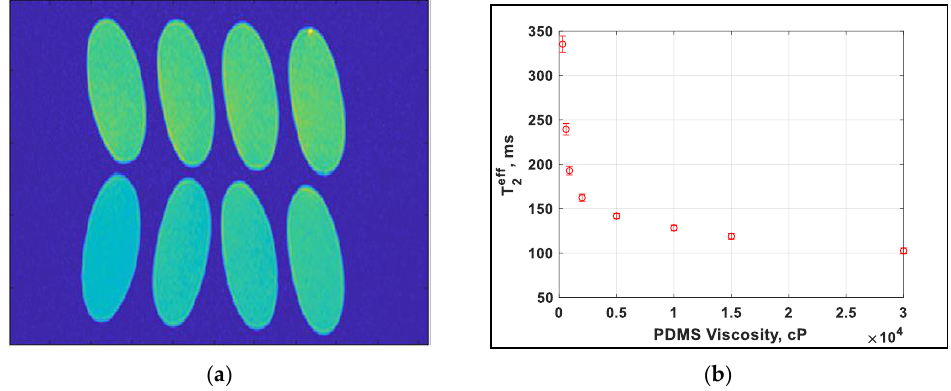
Figure 5. ( a ) Image of the final echo of the echo image from MRI showing the range of values experienced. Viscosity in cP is labelled ( b ) dependence of T 2eff on the PDMS viscosity. The values as determined for the T 2eff from the CAPIBarA are plotted against those from the MRI in Figure 6 and show a correlation between 0.4 and 0.5 that, importantly, is linear, thus demonstrating that this system works over the range of values needed to make useful predictions of placental health.